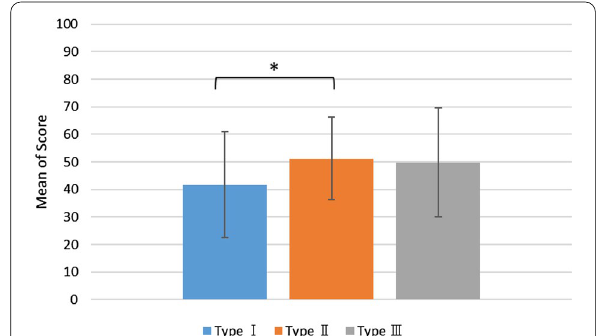
Fig. 11 Means of the score for each type during the attenuation activity (*p < 0.05)